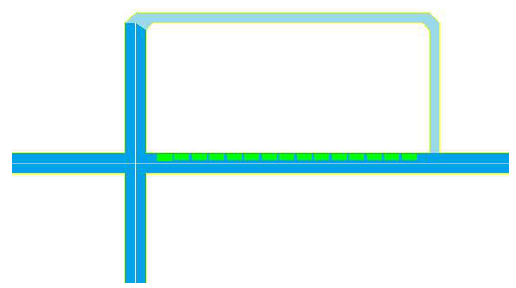
Figure 8. This Figure depicts a number of vehicles that stuck in the road behind the first vehicle.